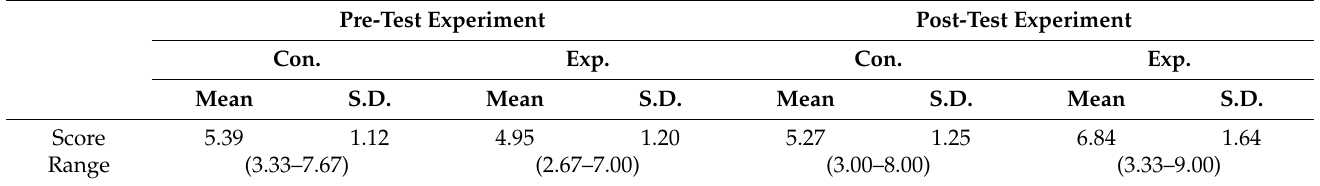
Table 3. The auscultation skill assessment results in control (Con.) and experimental (Exp.) groups. Pre-Test Experiment